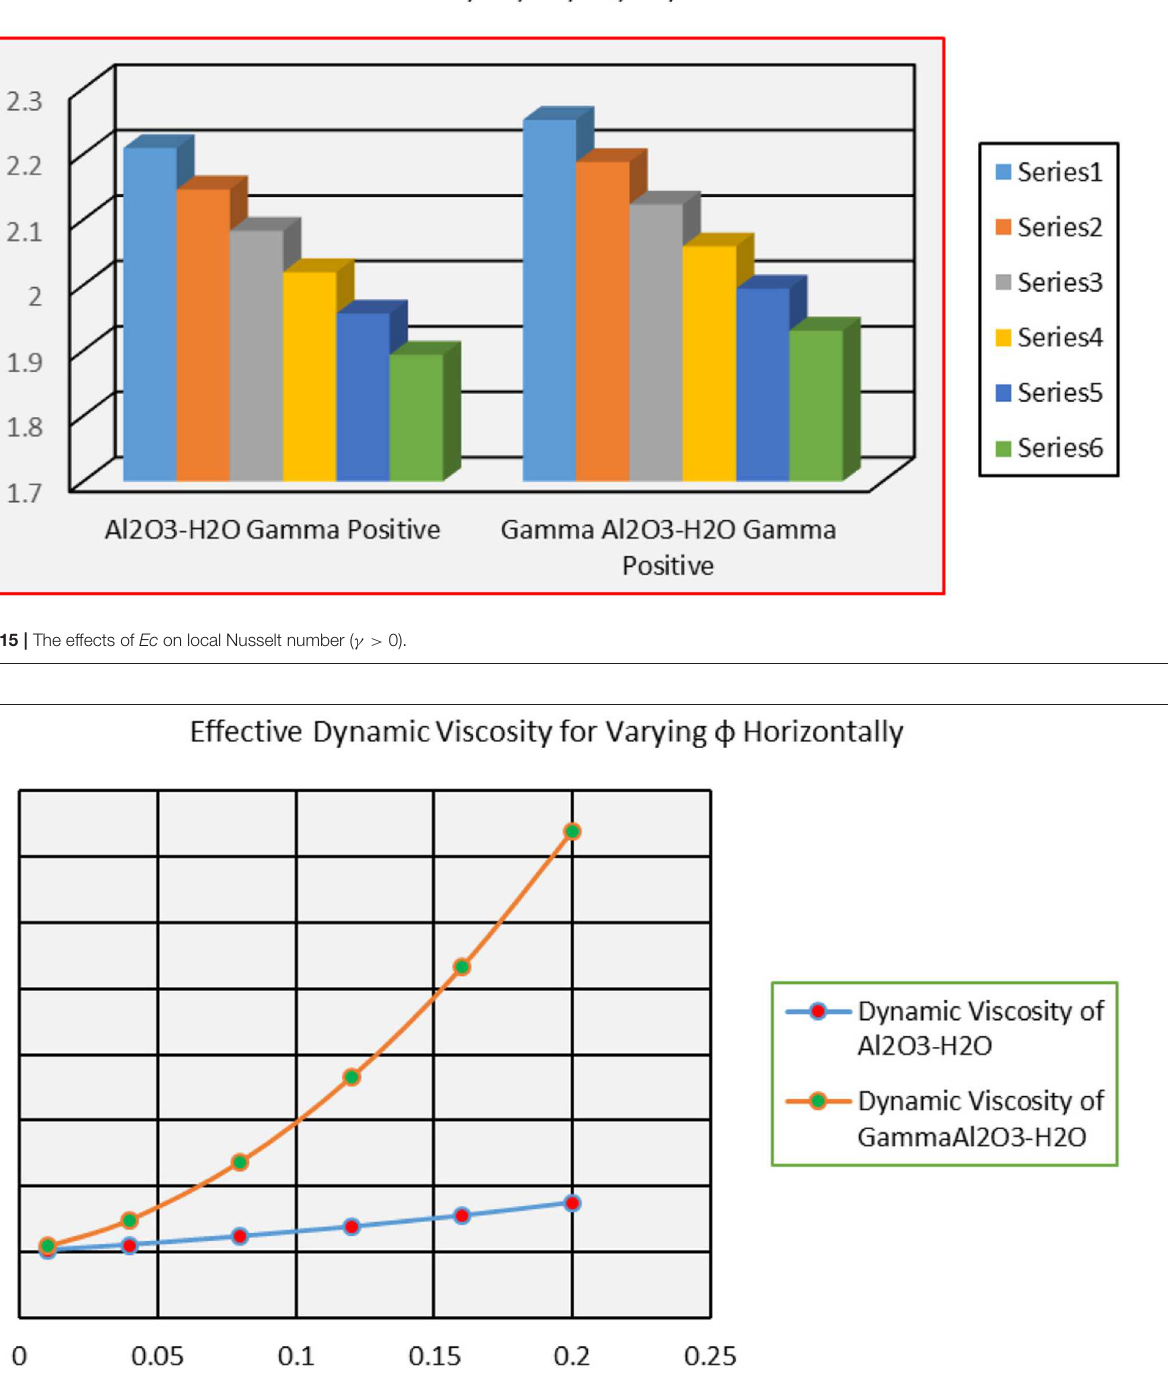
Frontiers in Physics |